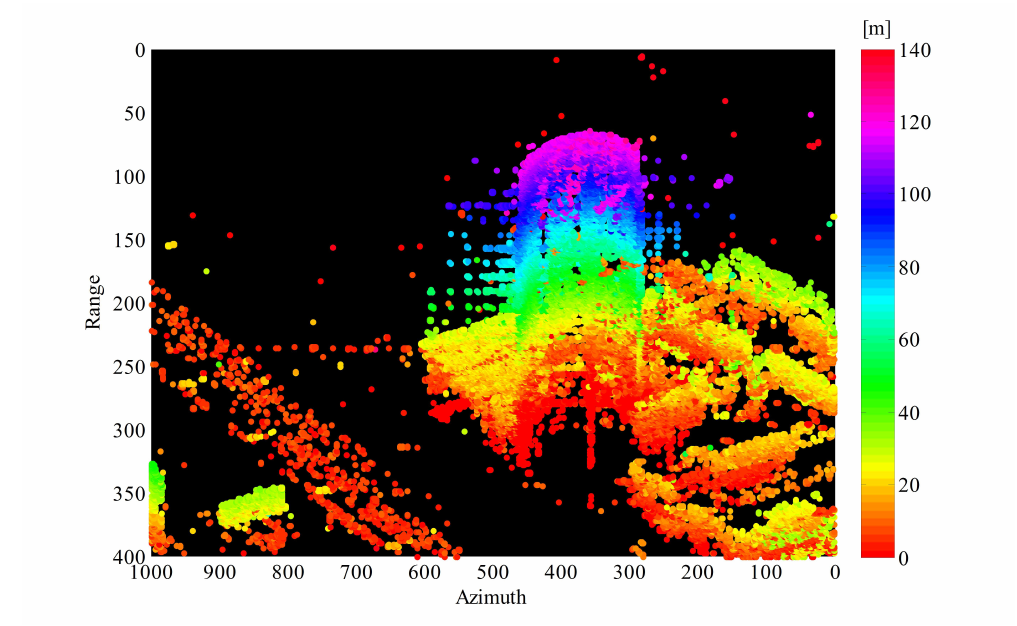
Figure 11. Study result: Height of single scatterers.